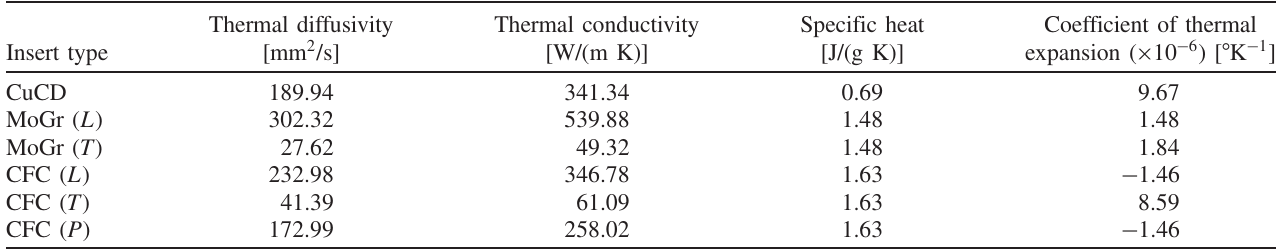
TABLE II. Thermal properties for HRMT-23 jaw absorbers.